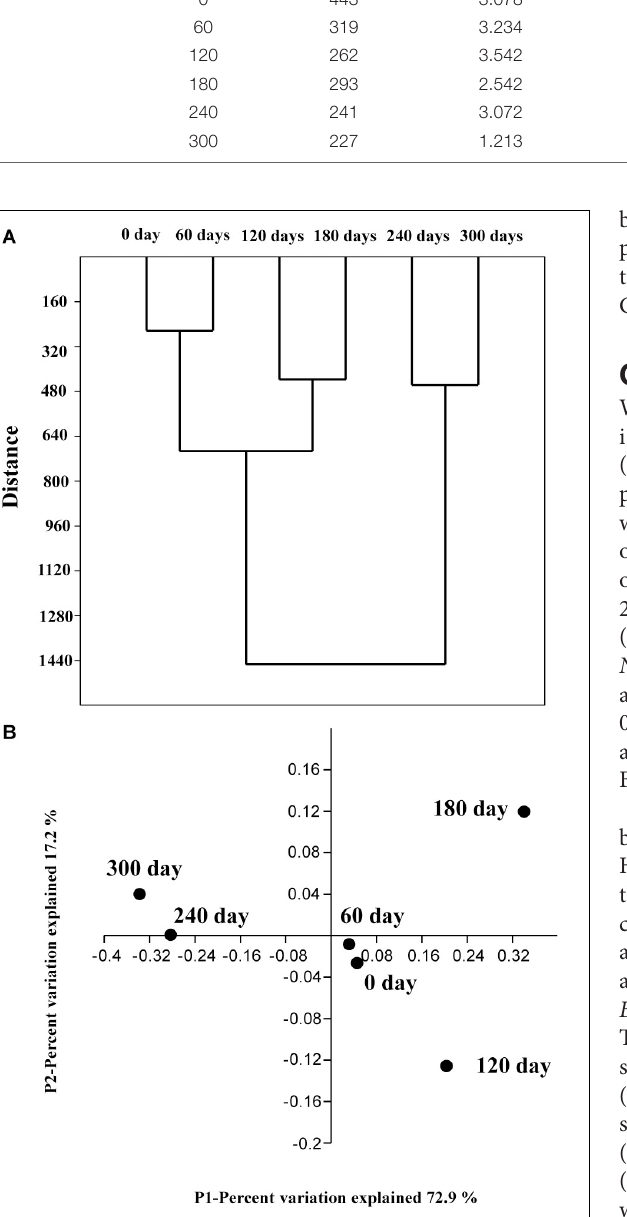
sample 2 (60 days), sample 3 (120 days), and sample 4 (180